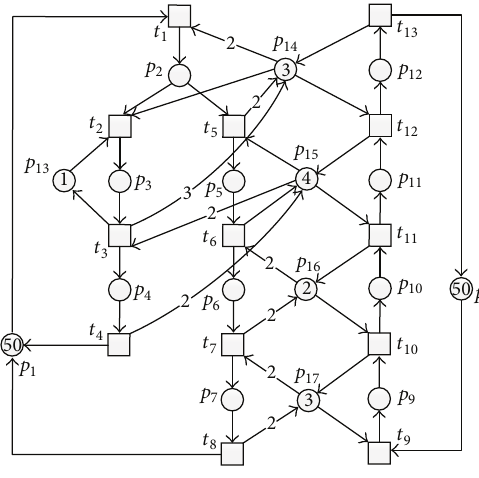
Figure 2: An S 4 PR net system (𝑁,𝑀 0 )